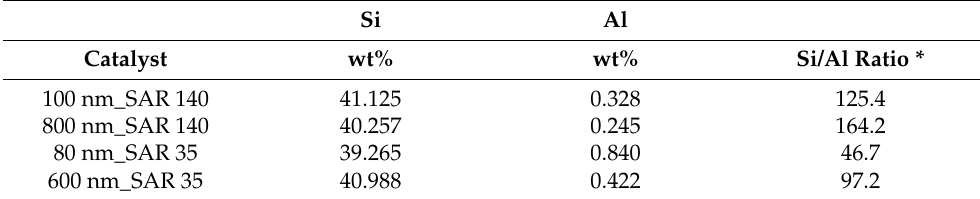
Table 2. Elemental analysis results of core–shell